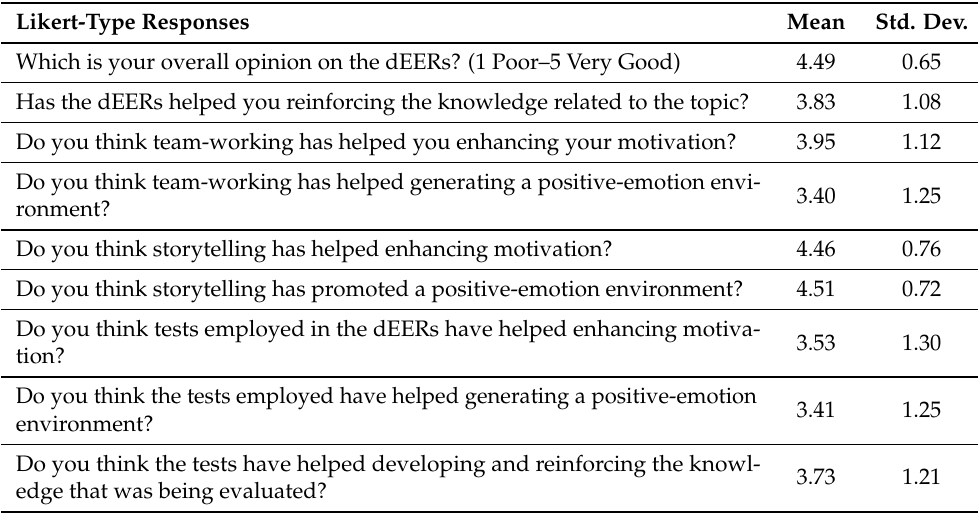
Table 5. Responses to Likert-type